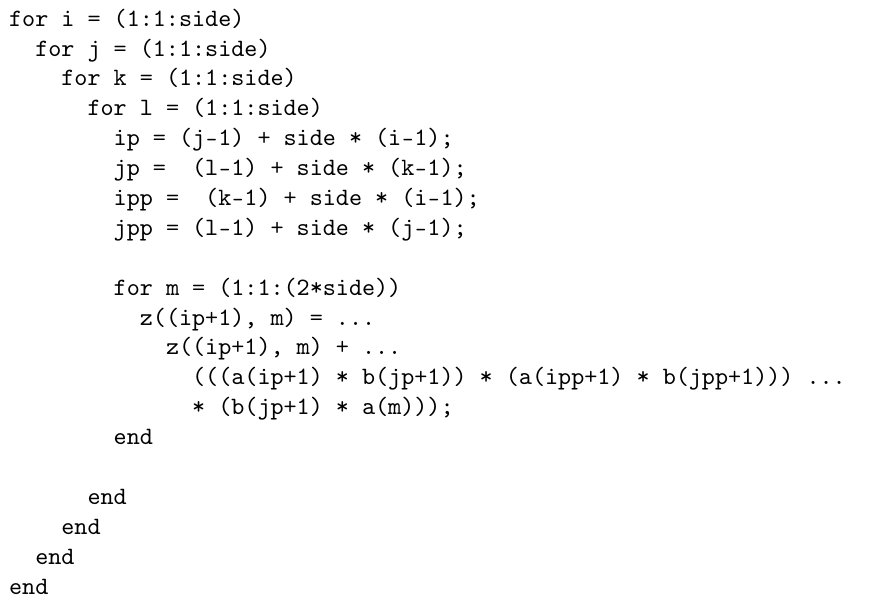
Figure 8. Algorithm in